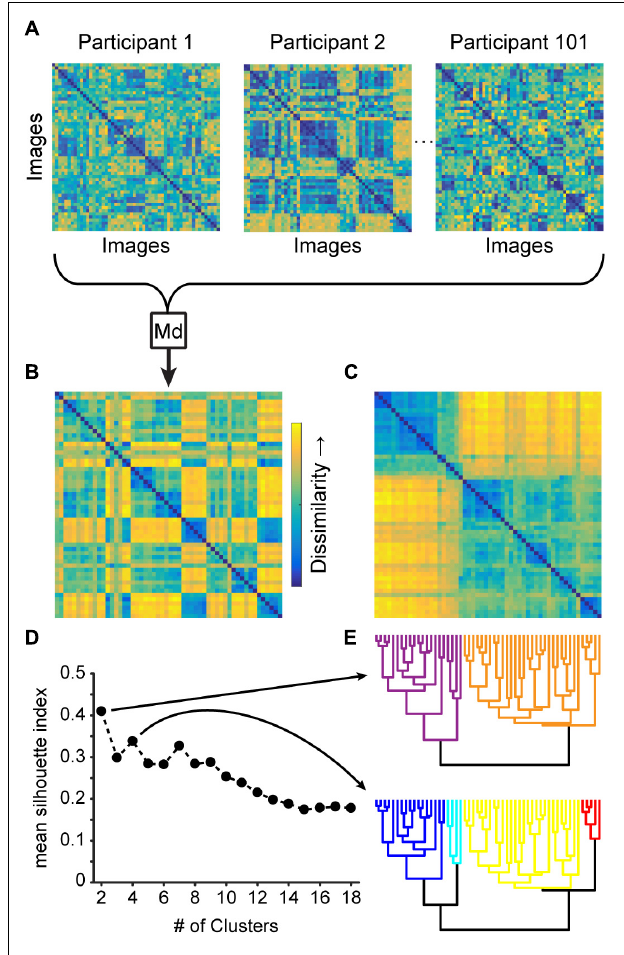
FIGURE 1 | (A) Having organized the 54 images on a computer screen based on the emotional similarity of the stimuli, a representation of each participant’s affective space was obtained via inverse multidimensional scaling, which can be visualized as a dissimilarity matrix depicting the distance between each pair of stimuli. (B) Computing the median (Md) of all 101 participant’s normalized affective spaces yielded a single group-median affective space, which (C) we reorganized based on (E) agglomerative hierarchical clustering. The clustering was validated with (D) the Silhouette index, which revealed 2- and 4-cluster solutions (as noted by the upticks, highlighted by the arrows). (E) The dendrograms underlying both clustering solutions are color-coded with warm colors reflecting the more positively valenced clusters and cool colors reflecting the more negatively valenced clusters (see section “Hierarchical